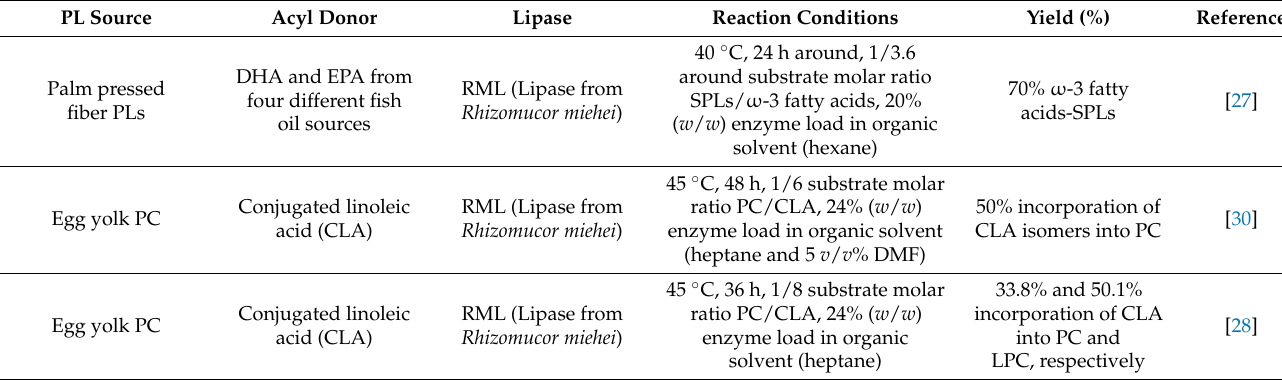
Table 2. Lipase-mediated of SPLs production by